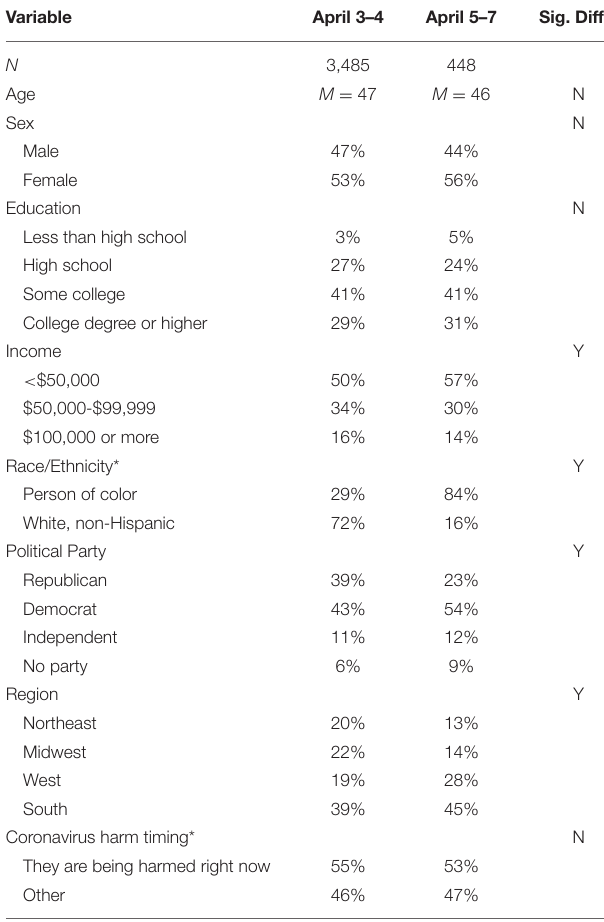
TABLE 1 | Sample characteristics and balance tests for differences across treatment groups.